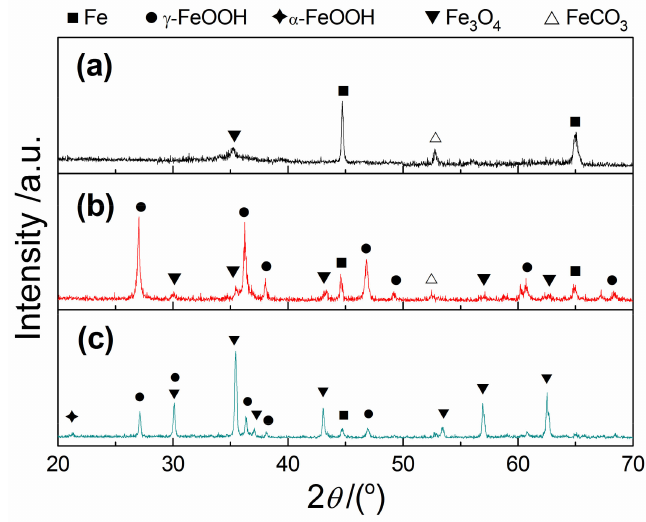
Figure 4. X-ray di ff raction patterns of corrosion product for X80 steel after EIS test in acidic soil simulated solution under typical conditions ( a ) pH ≈ 3.0 and DO ≈ 0.25 ppm; ( b ) pH ≈ 4.5 and DO ≈ 4.30 ppm; ( c ) pH ≈ 5.5 and DO ≈ 20.2